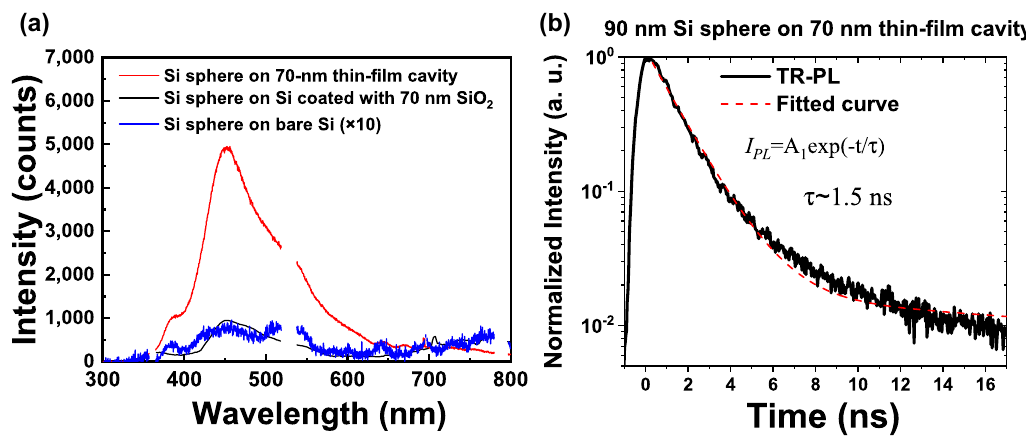
Figure 4: (a) Emission spectra of Si spheres (diameter: 90 nm) placed upon the various substrates. (b) Time-resolved PL intensity of Si spheres (diameter: 90 nm) placed upon a thin-film cavity.